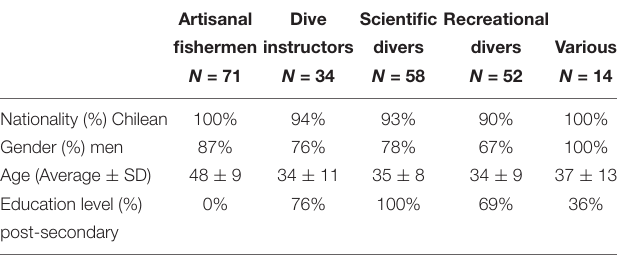
TABLE 2 | Demographic characteristics of diver types.